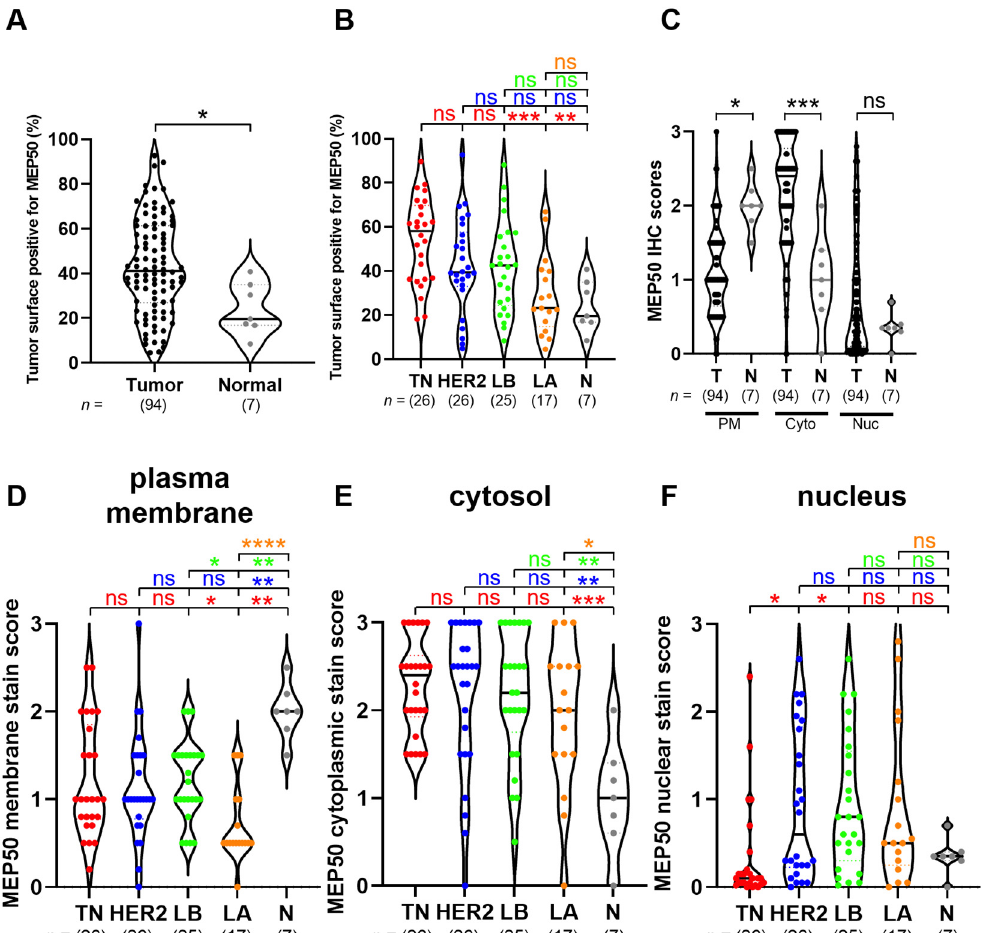
Figure 6. Differential subcellular localization of MEP50 among the breast tumor samples and normal breast tissues. Higher percentage of MEP50-expressing tumor cells compared to the normal breast tissues ( A ). Higher percentage of MEP50-expressing tumor cells in TNBC compared to the other breast cancer subgroups and normal breast tissues ( B ). Quantification of the tumoral surface positive for MEP50 staining represented as a percentage compared to the total epithelial surface ( A , B ). MEP50 staining was scored at the plasma membrane ( C , D ), in the cytosol ( C , E ) and in the nucleus ( C , F ) in the samples of the Curie cohort (from Figure 5). The score was obtained by combining the percentage and the intensity of the staining of the epithelial cells (0: no staining, 3: the strongest staining). Tumor (T, black), TNBC (TN, red), HER2 (blue), luminal B (LB, green), luminal A (LA, orange), and normal breast tissues (N, grey). PM: plasma membrane; Cyto: cytosol; Nuc: nucleus. The statistics in red indicate the comparison vs. TN, in blue vs. HER2, in green vs. LB, and in orange vs. LA: ns (not significant); * p < 0.05; ** p < 0.01; *** p < 0.001; **** p < 0.0001.